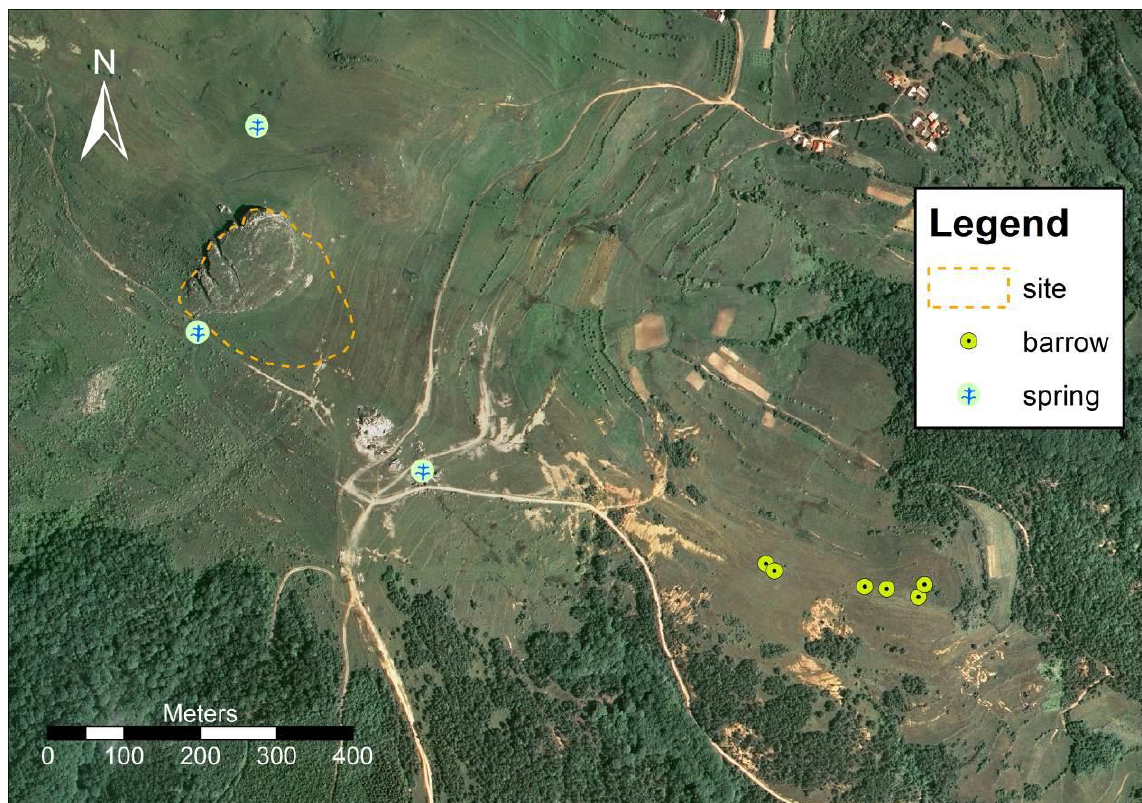
Figure 3. Aerial view of the area around the archaeological site. (Aerial photo from ANCPI orthophoto dataset.)